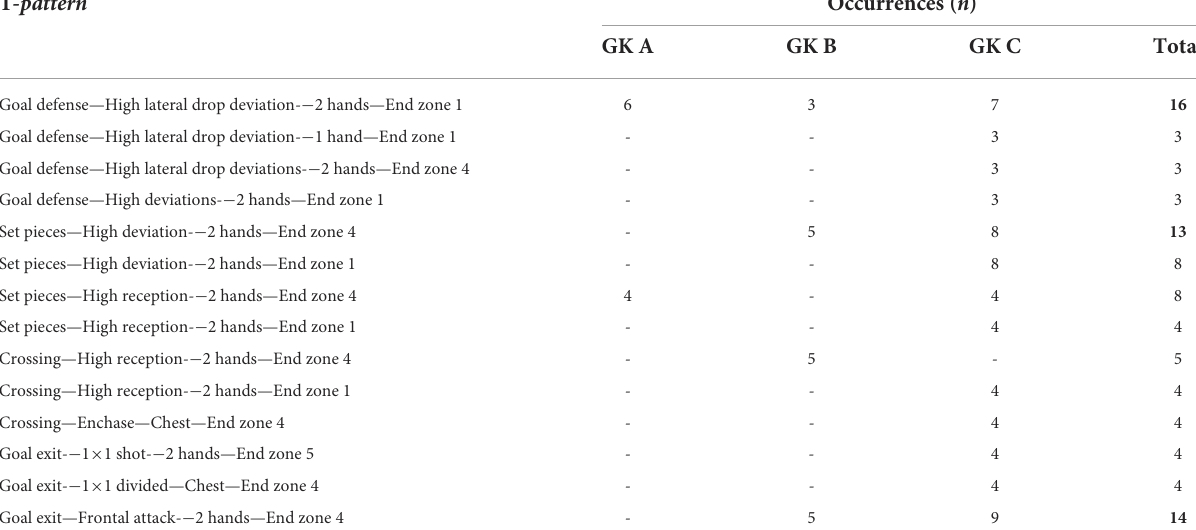
TABLE 4 T- patterns related to the GK defensive actions. T-